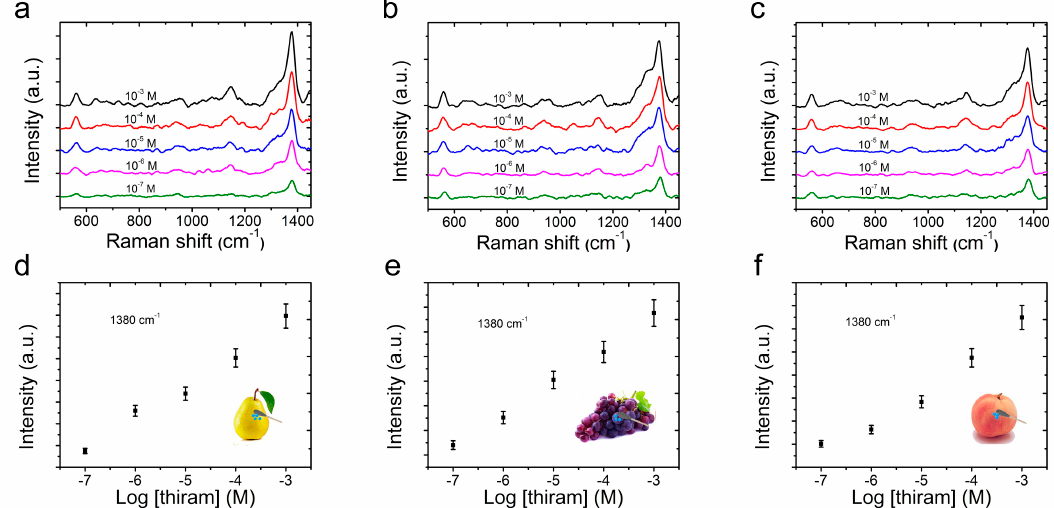
Figure 6. The SERS spectra of thiram with different concentrations collected by CS@PDA@AgNPs swabs through swabbing extraction on ( a ) pear, ( b ) grape and ( c ) peach surfaces. The relationship between the SERS peak intensity at 1380 cm − 1 and the corresponding logarithmic concentration of thiram molecules on ( d ) pear, ( e ) grape and ( f ) peach surfaces through a swabbing extraction.